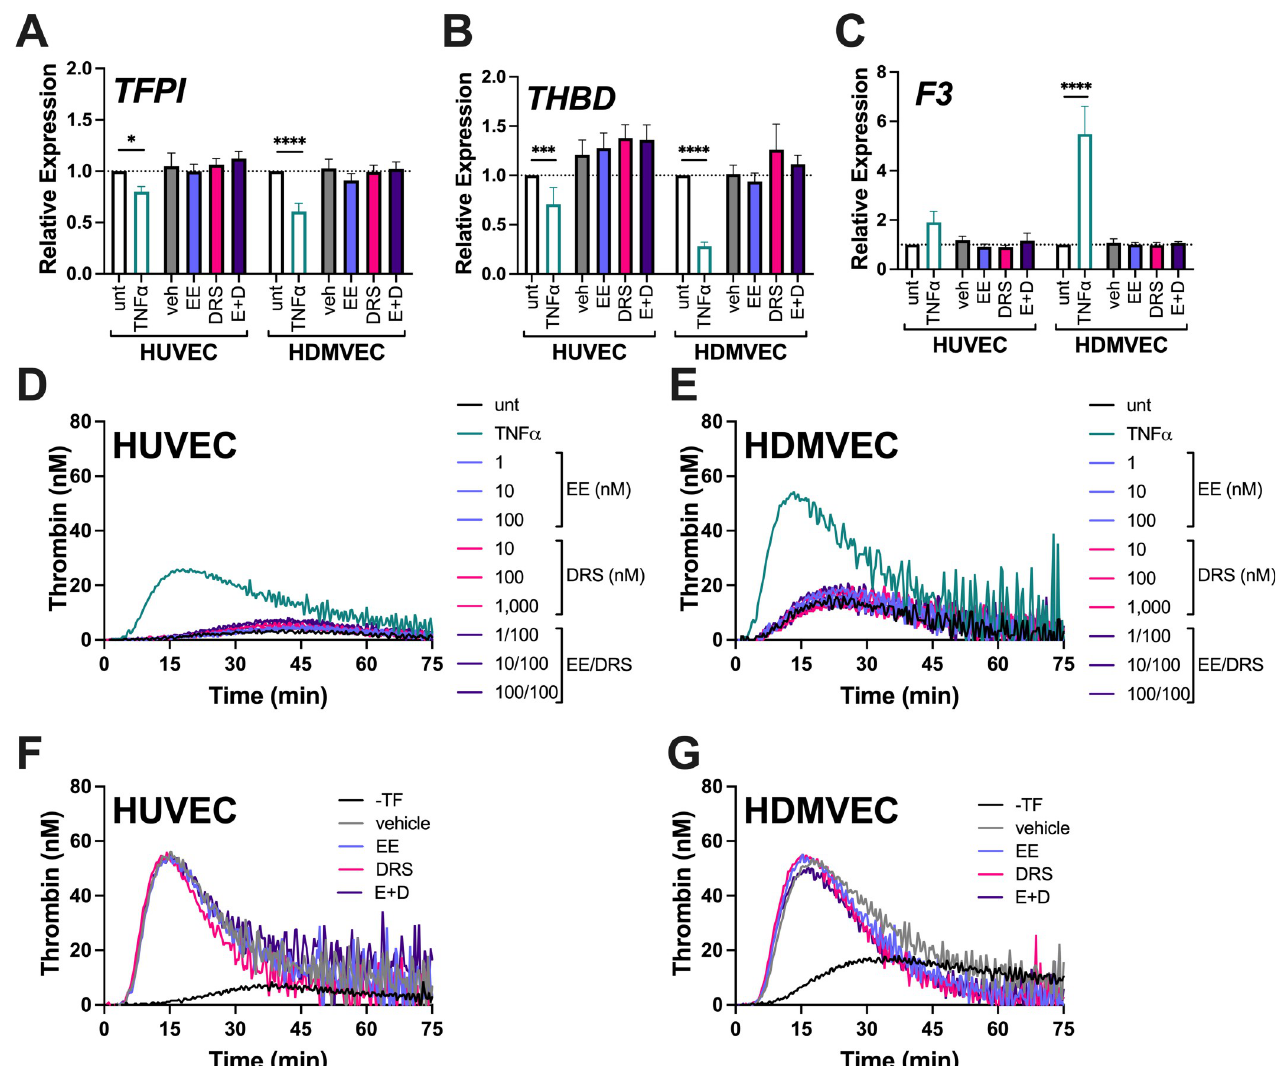
Fig 1. OC hormones do not enhance EC-supported thrombin generation. HUVEC and HDMVEC were treated with vehicle (0.7% ethanol [veh]), 10 ng/mL TNF ⍺ , 1 nM EE, 100 nM drospirenone (DRS), or EE and drospirenone (E+D) for 24 hours before RNA was extracted. Transcripts encoding (A) tissue factor pathway inhibitor ( TFPI ), (B) thrombomodulin ( THBD ), and (C) tissue factor ( F3 ) were measured by RT-qPCR and normalized to the untreated control (N = 3–12; Bars = mean + SEM; * p < 0.05, *** p < 0.001, **** p < 0.0001). ( D-G ) Thrombin generation was initiated in recalcified NPP by (D) HUVEC and (E) HDMVEC after 24 hours of TNF ⍺ , or EE and/or drospirenone. Curves are representative of N = 7 experiments performed in duplicate. Thrombin generation initiated by exogenous tissue factor and propagated by HUVEC (F) or HDMVEC (G) was measured in NPP (N = 3). Thrombin generation parameters and statistical analyses are provided in S2